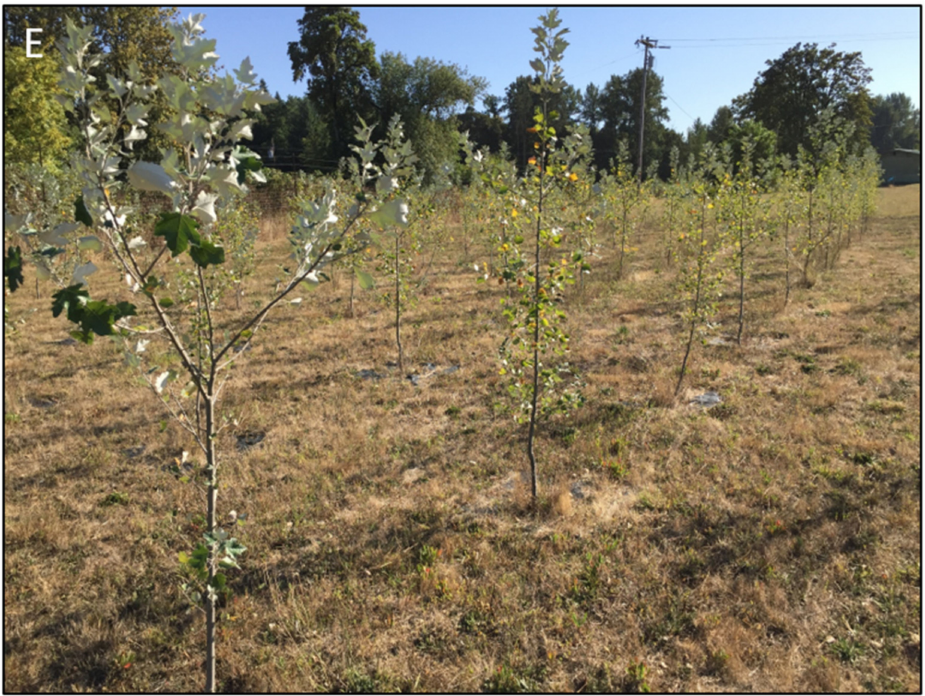
Figure 1. Field site overviews from 2019. ( A ) In spring 2019, WT trees had numerous large catkins, ( B ) WT catkins were fully open prior to leaf bud flush. ( C ) Sterile RNAi- LFY trees had numerous tiny catkins that opened late, ( D ) tiny catkins were still mostly enclosed by bud scales prior to leaf bud flush. ( E ) Field site overview in summer